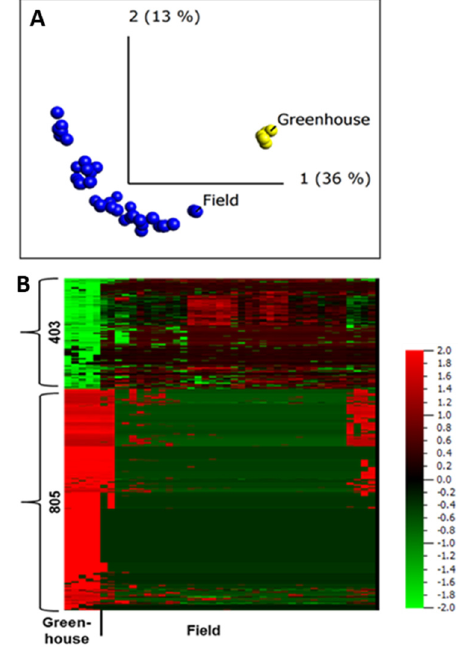
Figure 4. Quantitative analysis of apoplastic proteome samples isolated from potato cultivar Bintje grown under greenhouse and field conditions. ( A ) Unsupervised principal component analysis plot of all the samples. Each circle represents one biological replicate; ( B ) heat maps and numbers of peptides up- and down-regulated under greenhouse and field conditions according to a two-group comparison in Qlucore with a false discovery rate < 0.001 (according to the Benjamini − Hochberg procedure for determining q). The heat map of the differentially regulated peptides ( q < 0.001) was sorted using hierarchal clustering and red represents higher abundance (Fold change,